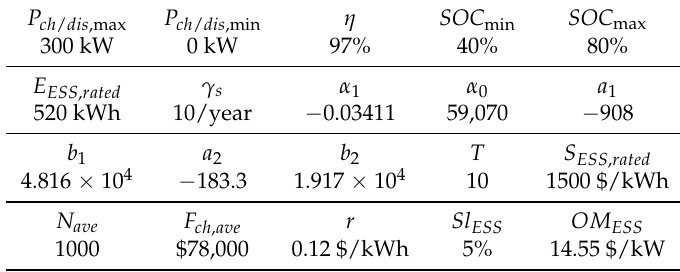
Table 2. Operation and economic parameters for hybrid energy storage systems [34].